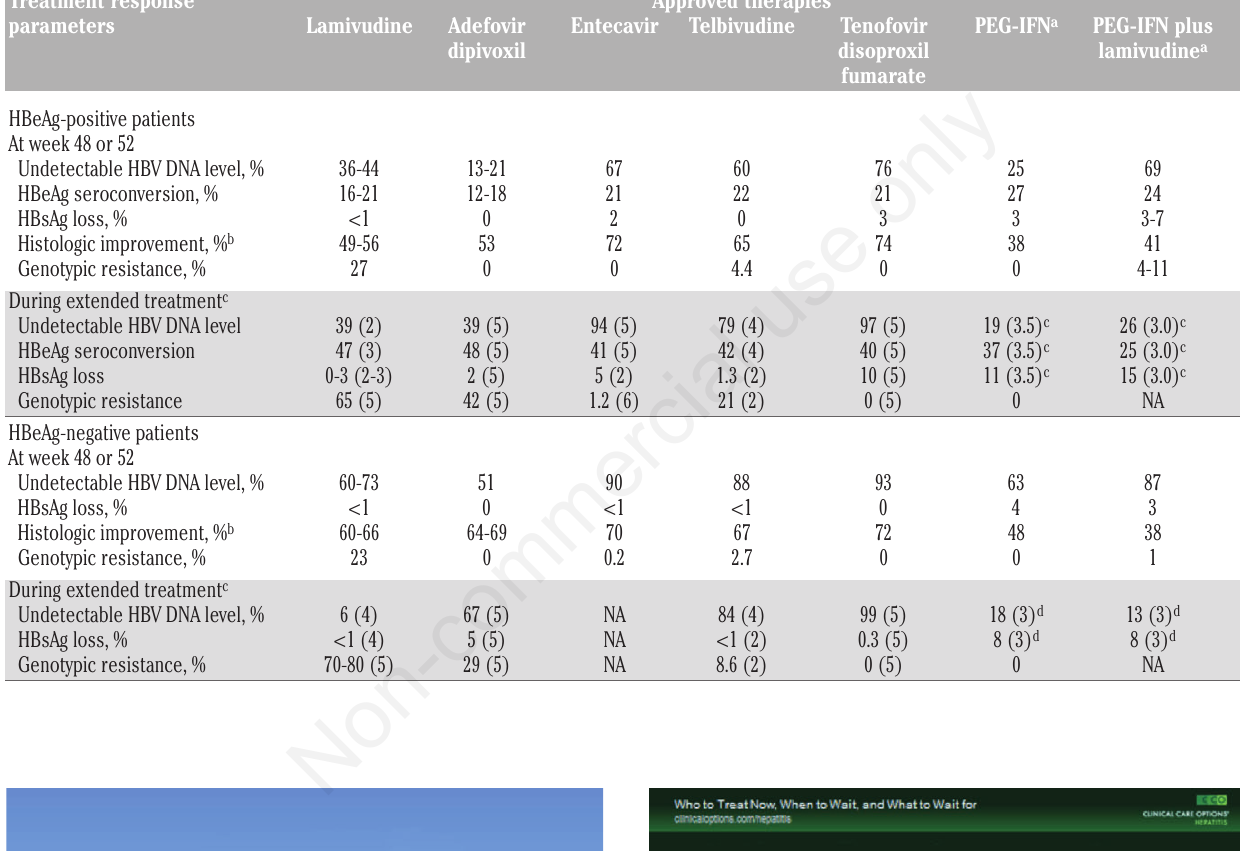
Table 1. Response rates and genotypic resistance rates to approved therapies in HBeAg-positive and HBeAg-negative patients. Treatment